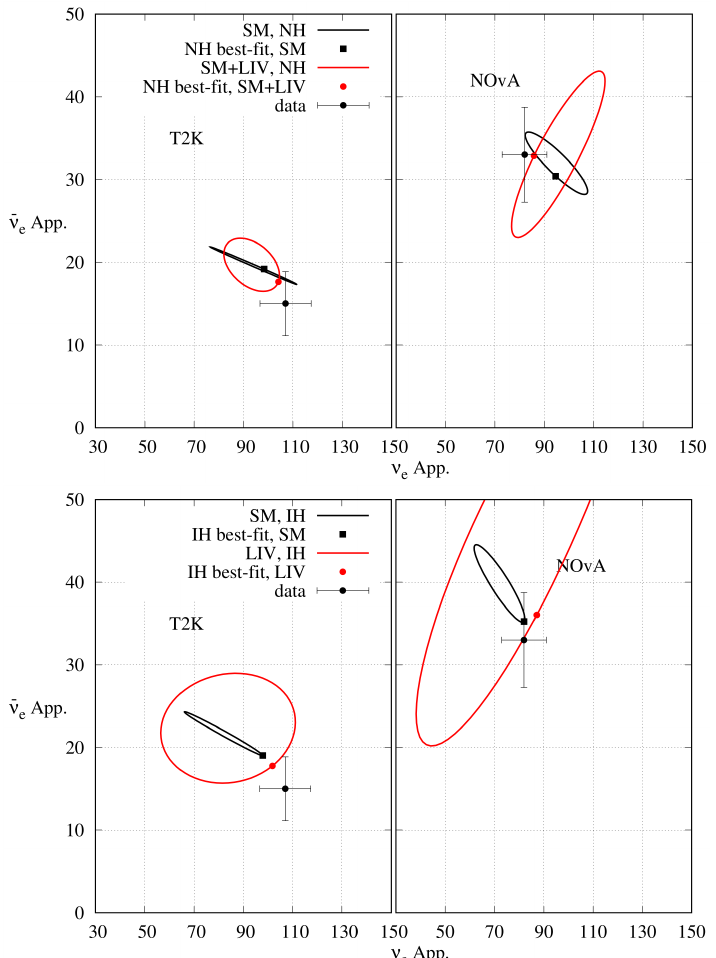
Figure 12. Bi-event plot for T2K (NO ν A) in left ( right ) panel. The upper ( lower ) panel is for NH (IH). To generate the ellipses, δ CP has been varied in the range [ − 180 ◦ :180 ◦ ] while keeping all other parameters fixed at the combined best-fit values. The black (red) ellipses represent the SM (LIV) case with the best-fit points indicated by a black square (red circle). The ellipses and the best-fit points have been determined by fitting the combined data from NO ν A and T2K. The black circle with error bars represent the experimental